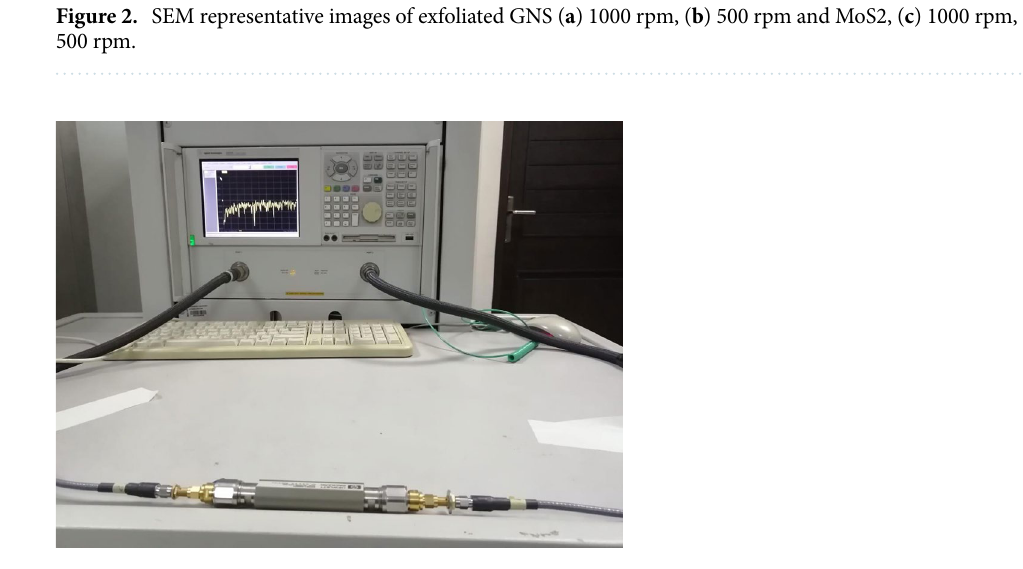
Figure 3. The vector network analyser test setup utilized for S-parameters